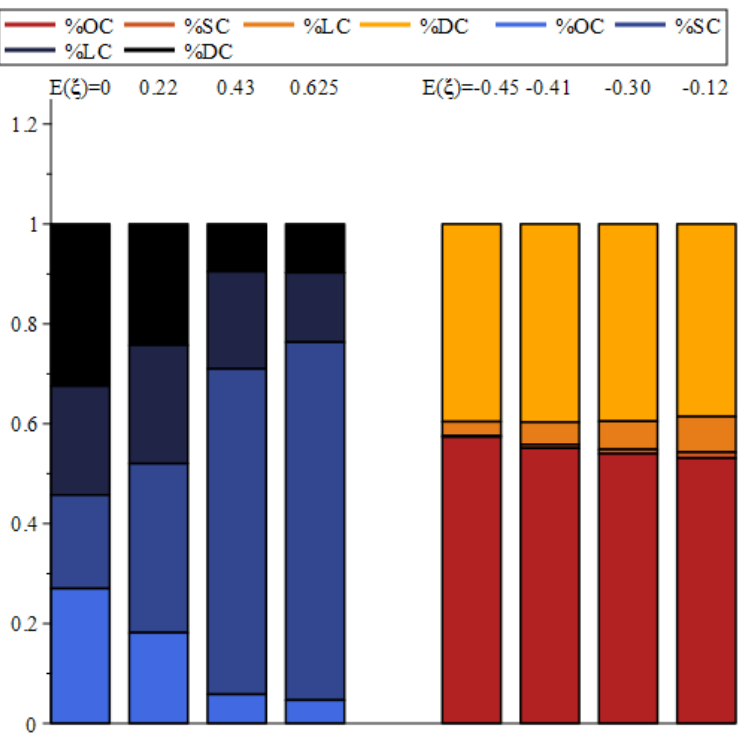
Figure 8. The %cost components, Scenario